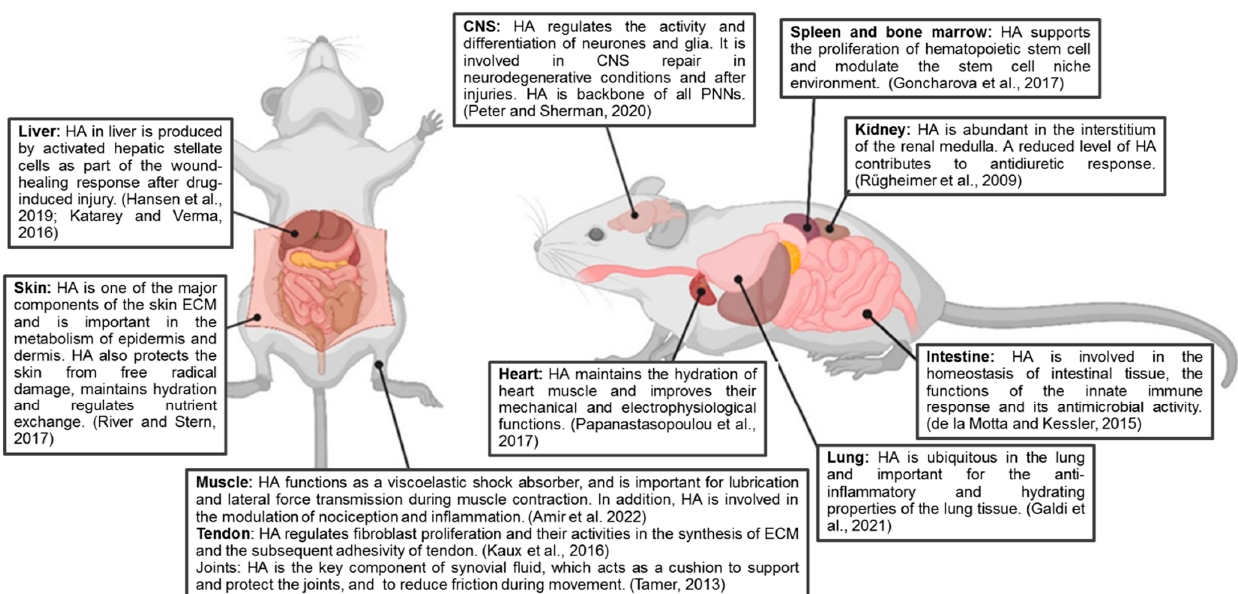
Figure 9. Schematic representation showing the diverse biological functions which HA is involved. Created with BioRender.com, Refs. [21,29,32–40].